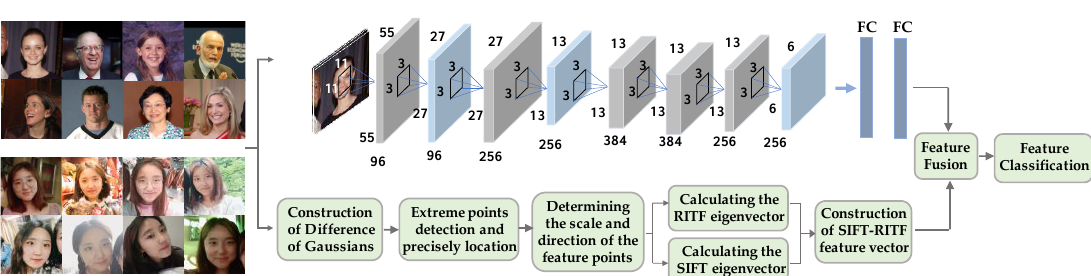
Figure 1. The schematic diagram of SR-CNN model, combining the rotation-invariant texture feature (RITF) vector, the scale-invariant feature transform (SIFT) vector, and the convolution neural network (CNN).